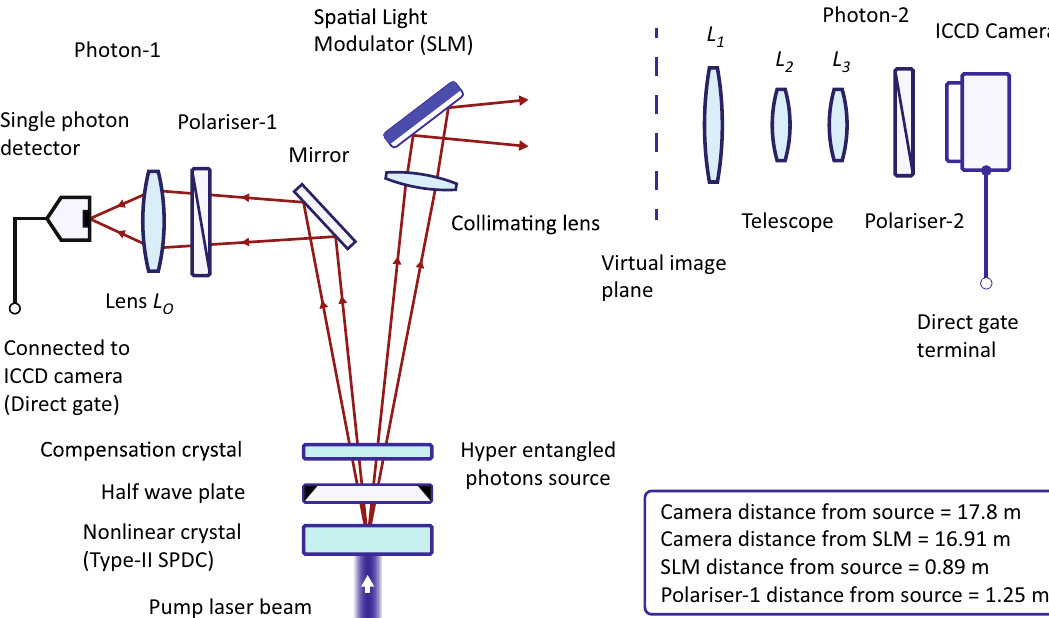
Figure 2. Main schematic diagram of the experiment. Hyper-entangled photons are produced by a BBO crystal. A polarisation sensitive phase pattern is produced by an SLM. The pattern is imaged in free space by ICCD camera located at 16.91 m from the pattern by a lens combination in a telescopic configuration. ICCD camera is activated by a measurement outcome event signal of photon-1 to register photon-2 to form a quantum